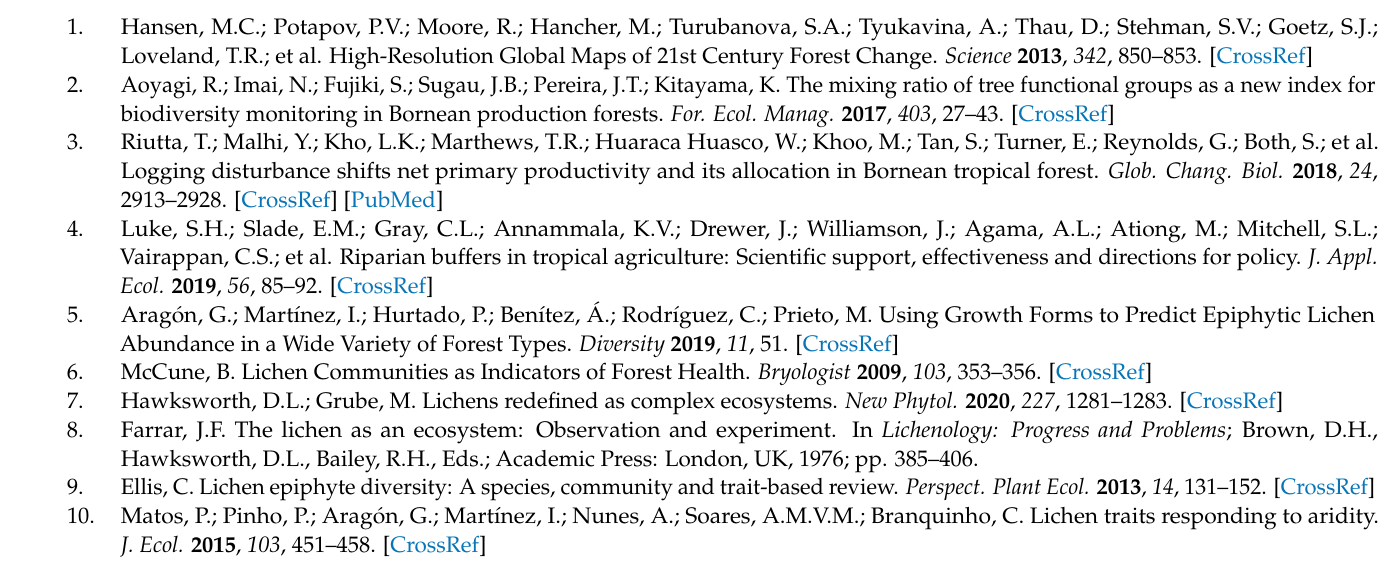
groups, Table S2: Frequencies of functional groups, Table S3: Lichen traits matrix, Table S4: Tree taxa and traits observations, Table S5: PerANOVA results of site effects on tree traits, Table S6: Results of Indicator Value analysis of lichen